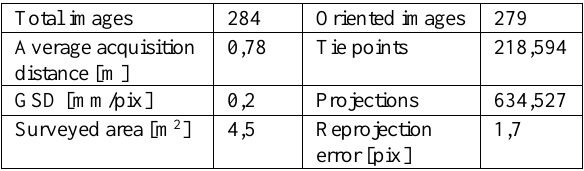
Table 7 . Characteristics of the photogrammetric dataset collected on the second day of the survey.